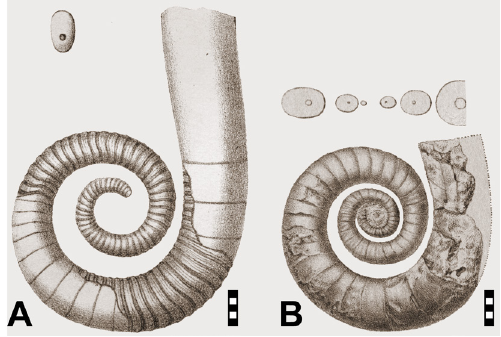
Fig. 37. Lituites perfectus Wahlenberg, 1818; reproductions of illustrations of Remelé (1890). A . Specimen MB.C.11622 from Eberswalde (Brandenburg), illustrated by Remelé (1890: pl. 1 fig. 2). B . Specimen MB.C.11646 from Eberswalde (Brandenburg), illustrated by Remelé (1890: pl. 6 fig.